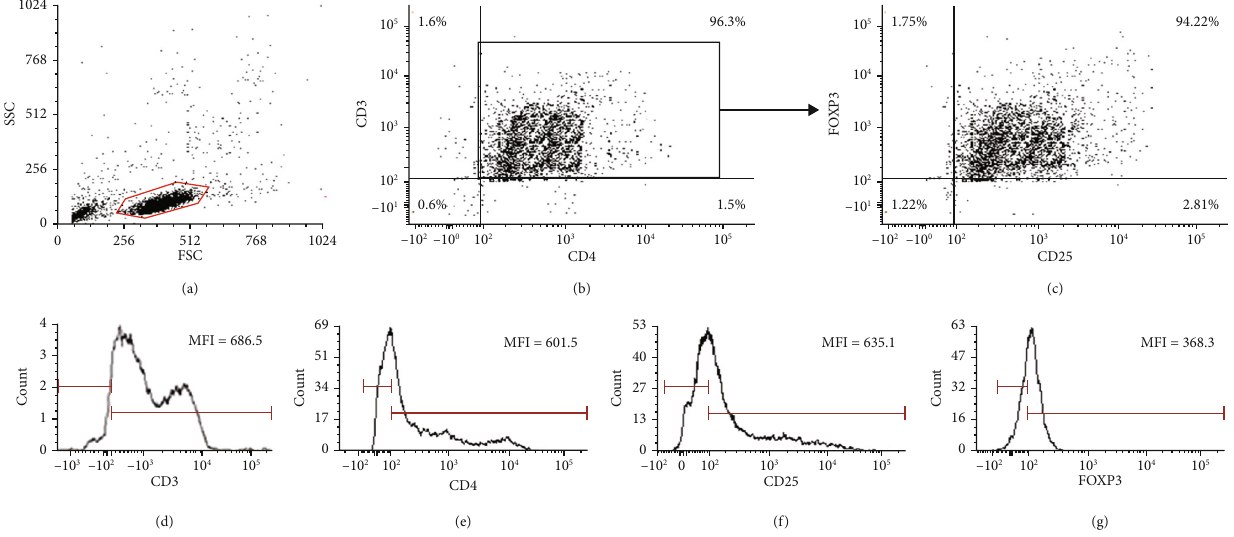
Figure 1: Gating strategy for CD4 + CD25 + FOXP3 + Treg cells. Estimation of protein levels of CD4, and CD25. (a) Lymphocytes were gated on the basis of size and morphology. (b) CD3 + CD4 + T cells were gated on the basis of CD3 and CD4 expression.(c) Treg cells were gated on the basis of CD3, CD4, CD25, and FOXP3 expression. The purity of isolated CD3 + CD4 + CD25 + FOXP3 + Treg cells was found to be 94.22%. (d) Expression of CD3 in T cells. Representative graph shows the amount of CD3 in the T cells as mean fl uorescence intensity (MFI). (e) Expression of CD4 in T cells. Representative graph shows amount of CD4 in the T cells as mean fl uorescence intensity (MFI). (f) Expression of CD25 in T cells. Representative graph shows amount of CD25 in the T cells as mean fl uorescence intensity (MFI). (g) Expression of FOXP3 in T cells. Representative graph shows amount of intracellular FOXP3 in the T cells as mean fl uorescence intensity